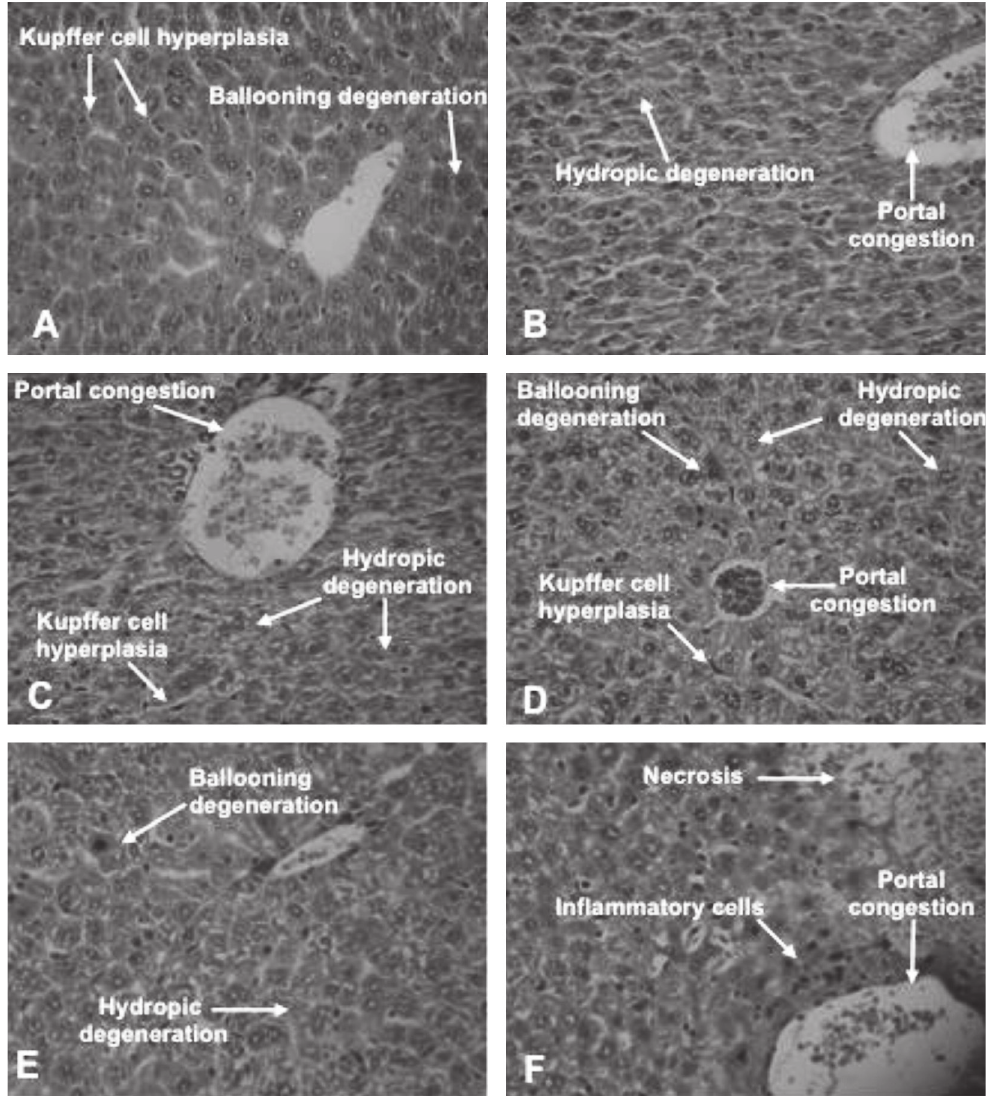
Figure 6 - Histology of livers removed from untreated or N -phthaloyl amino acid derivatives-treated mice with 50 mg/kg/day after 7 days. A – Control (4 % DMSO); B – Thalidomide; C – 5-Fluorouracil (25